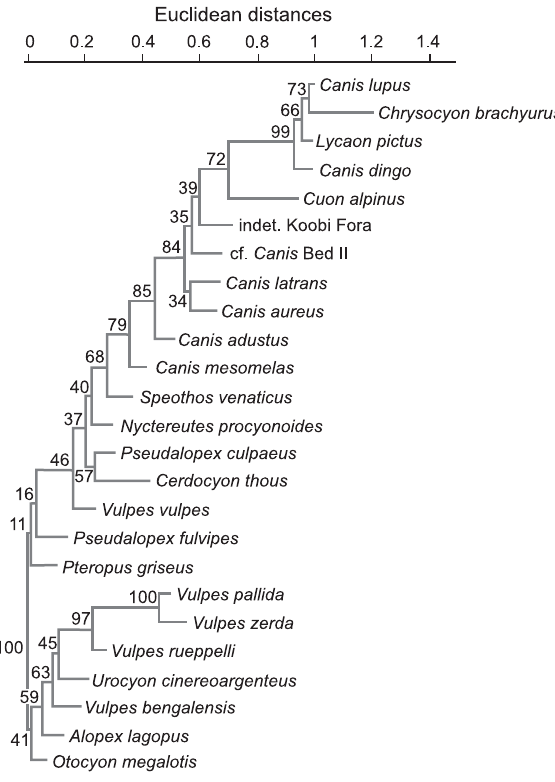
Fig. 6. Neighbour-joining cluster analysis performed using Euclidean dis- tances extracted from distal measurements. Bootstrap values show the sup- port for each internal